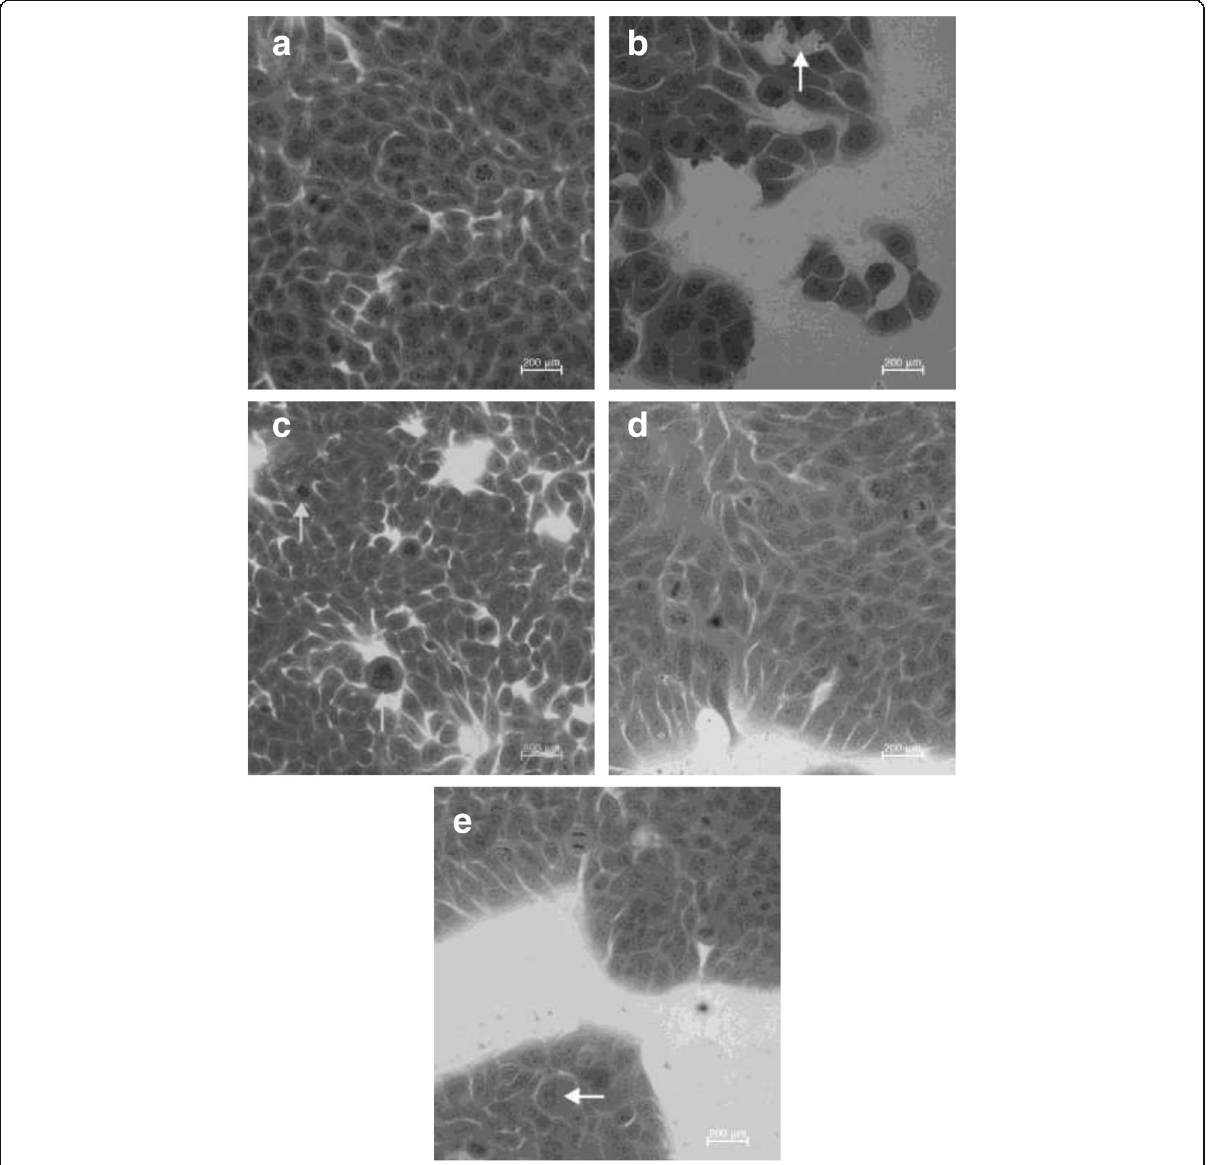
Fig. 3 Untreated cells ( a ) and HT-29 cells exposed to 100 μ g/mL CPK-H (24 h) ( b ) and CAK-Tot extract (48 h) ( c ), 1000 μ g/mL SPK-Tot ( d ) and 500 μ g/mL SAK-H (72 h) extracts ( e ). HT-29 colon cancer cells, mostly found in interphase, form colonies of round to elliptical shapes. Round nuclei with 2 – 4 prominent nucleoli with uniform sized cells are visible. Treated HT-29 colon cancer cells ( b ) show membrane blebbing (arrows) indicative of apoptosis formation, hypercondensed chromatin ( c ) and cellular shrinkage ( d and e ). Figure 3a, c, d, and e (magnification 40x), and 3b (magnification